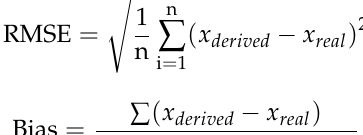
Table 4. ECG-derived respiration algorithm results (clinical patient).